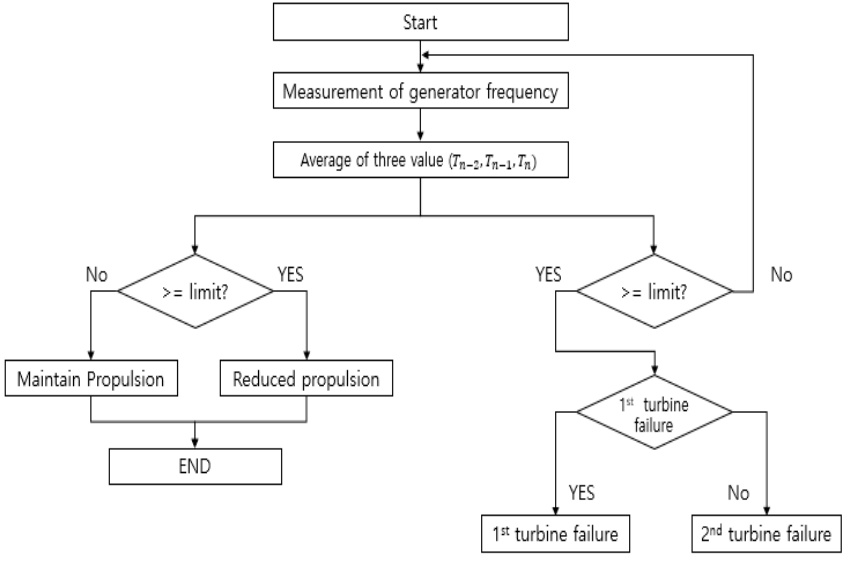
Figure A5. Relationship with parameters for PMS.